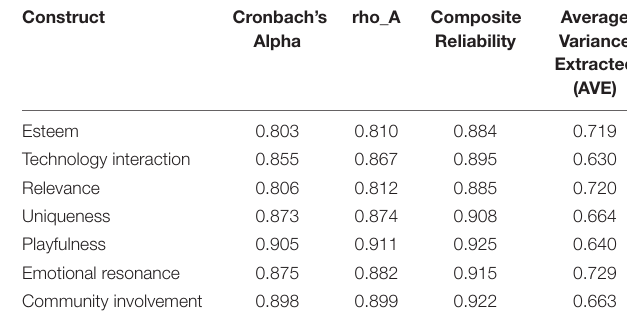
TABLE 2 | Reliability and validity indicators of the research